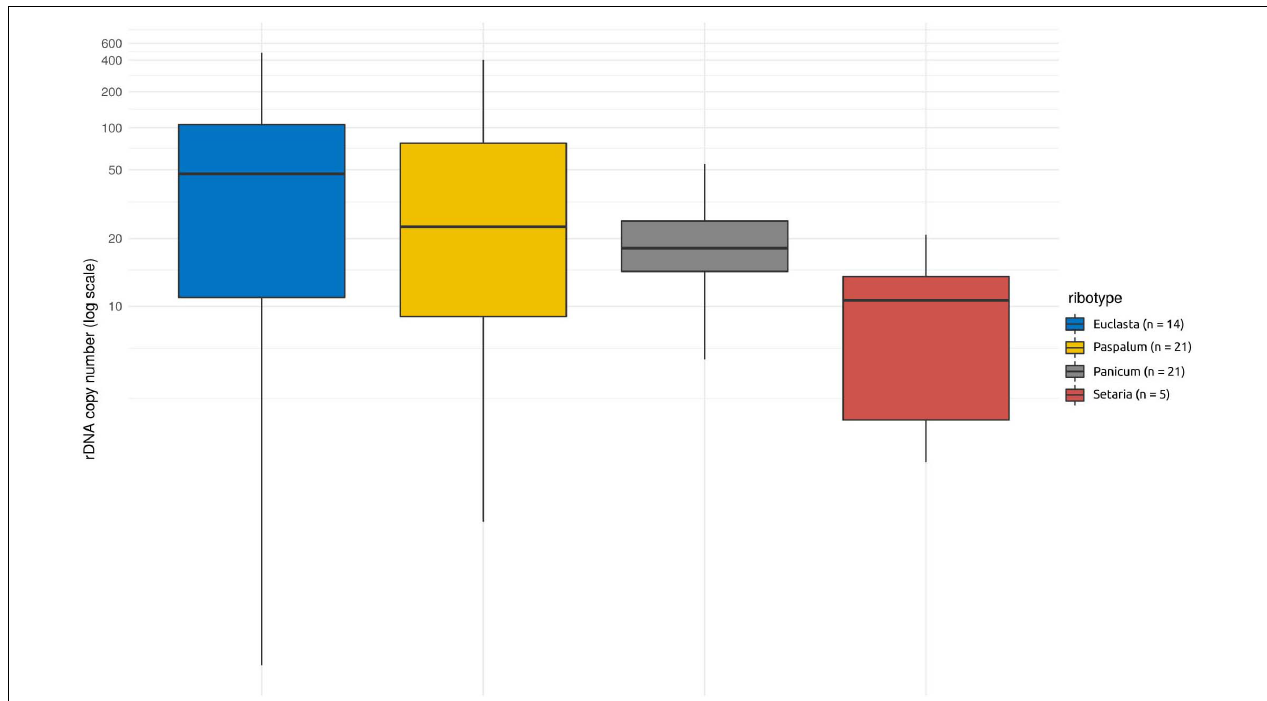
FIGURE 2 | Copy number variation within and among the foreign ribotypes in Hordeum species of sect. Stenostachys . No significant differences at P = 0.05 were detected using ANOVA.